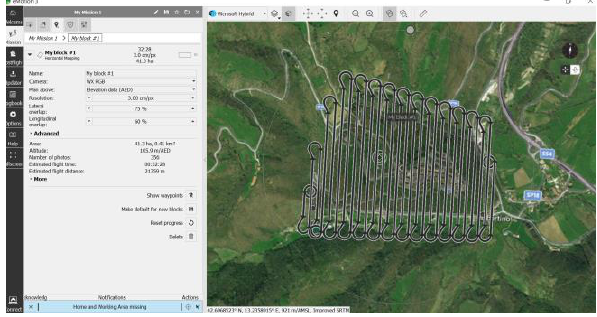
Figure 3. The flight planning interface in eMotion 3.